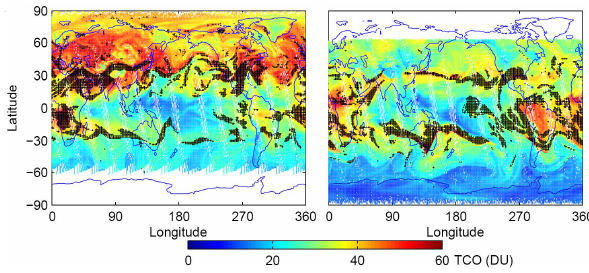
Fig. 2. CTM TCO (colour, unit: DU) co-located with TF events (black “+”) for 25-h periods beginning 00:00:00UTC on 10 June (left) and 3 December (right)